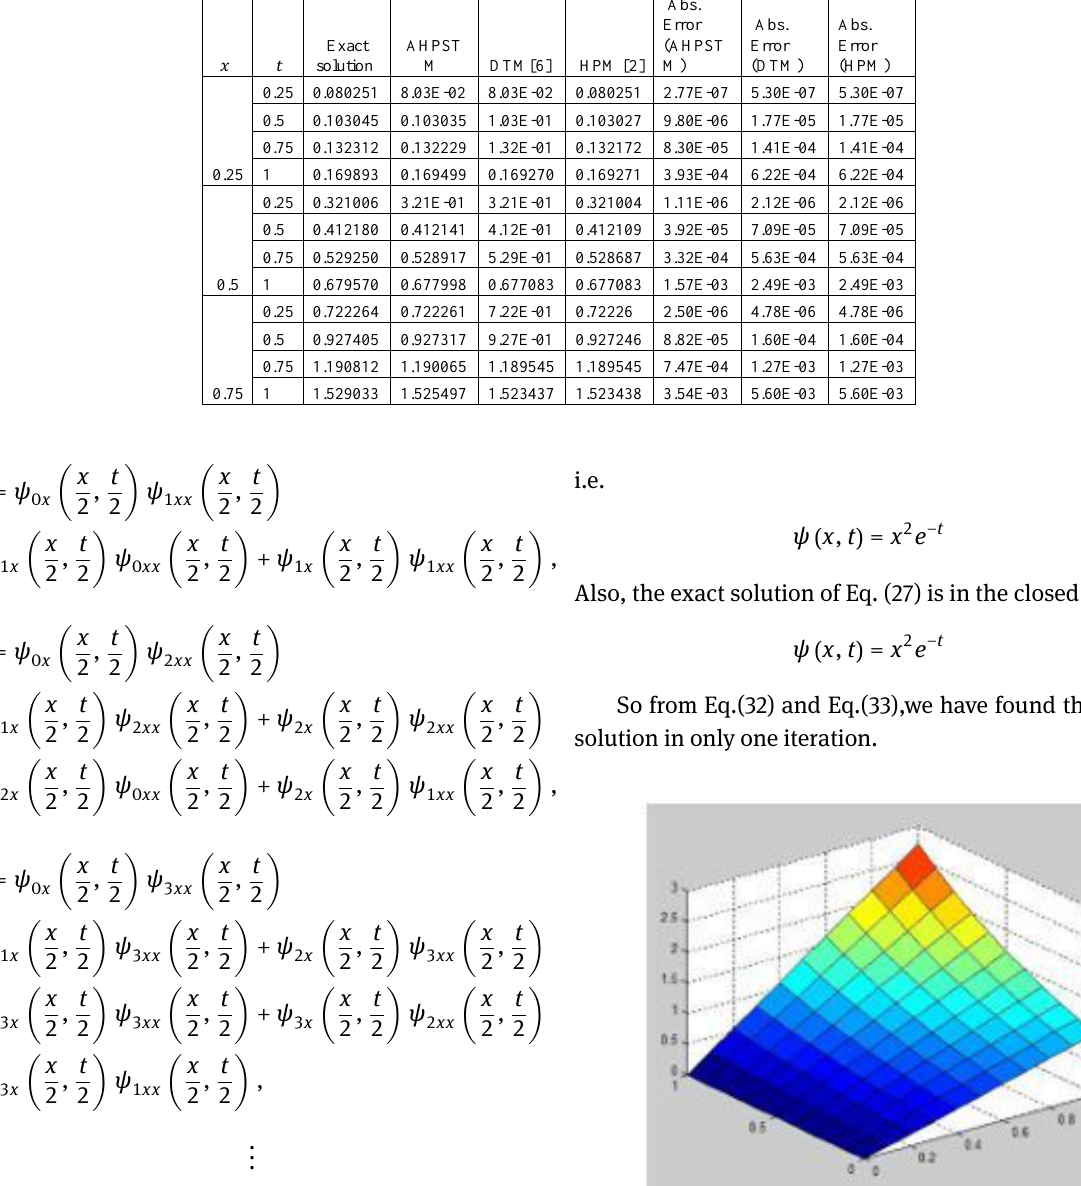
Abs. Error (AHPST M)